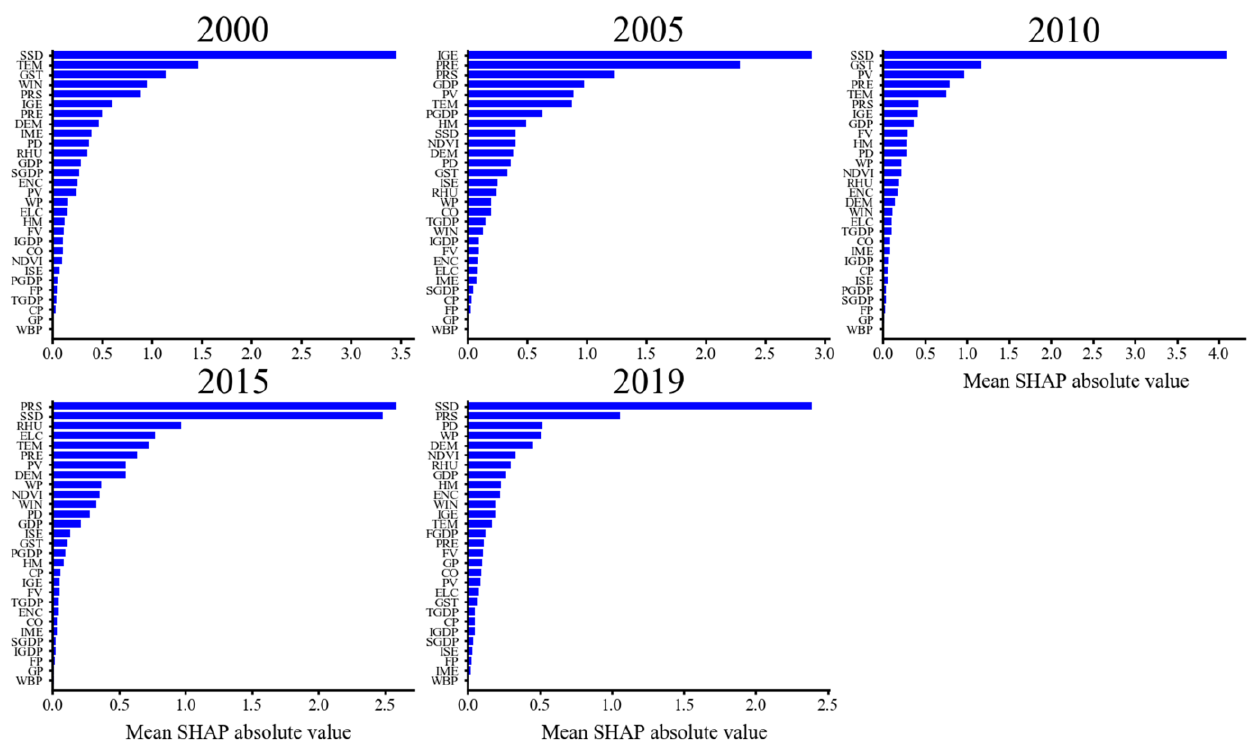
Figure 4. The relative importance of PM 2.5 concentrations influencing factors based on the mean absolute SHAP values for each of the selected years.